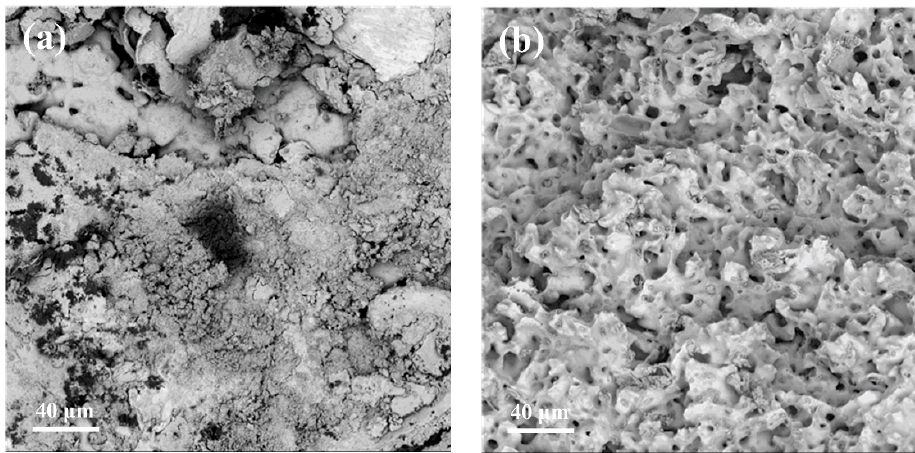
Figure 9. SEM micrographs of 20 nm fouled stainless steel membrane: ( a ) membrane layer (1000×); ( b ) support layer (1000×).